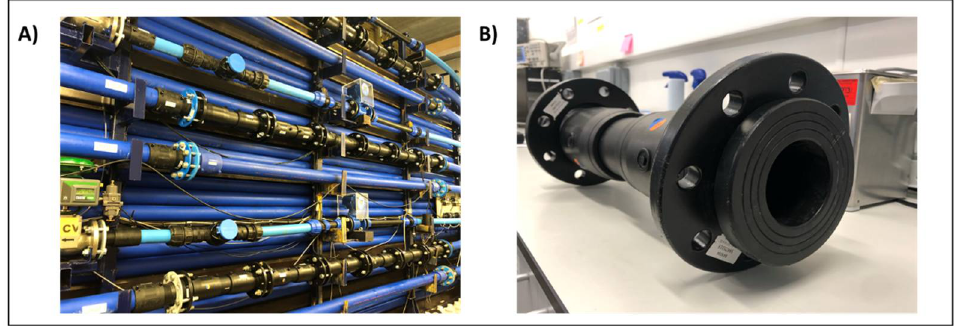
Figure 1. ( A ) Full scale experimental DWDS facility composed of 3 individual loops; ( B ) removable pipe sections used for biofilm sampling.